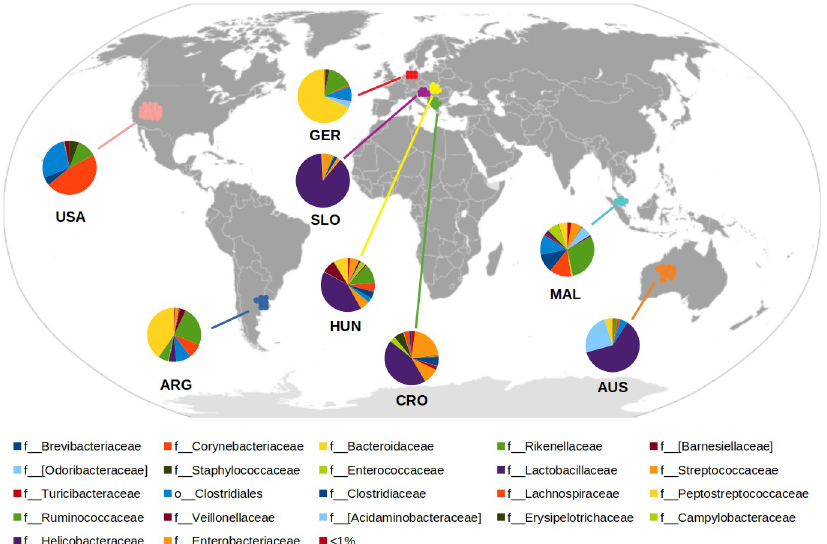
Fig 2. Geography map of chicken GIT microbiota at the family level. Different colors are used to indicate each individual taxon according to the country of origin designated as AUS: Australia, ARG: Argentina, CRO: Croatia, GER: Germany, HUN: Hungary, MAL: Malaysia, SLO: Slovenia, and USA: United States. The taxonomic classification: p_phylum, c_class, o_order, and f_family. https://doi.org/10.1371/journal.pone.0244724.g002 farm (AE). The analysis consisted of ET samples involves in the previously analysis, and other 17 samples of the same datasets from different ages (Table 1), and 27 samples obtained from CF (S1 Table). A total of 3032606 quality trimmed sequences and 1172 different OTUs, were obtained with an average number of sequences per sample of 49168, 49881, 69817, and 49297, for ET1, ET2, CP, and AE respectively. The distribution of the experimental and commercial datasets gathered into different groups according to the multidimensional scaling analysis (PCoA based on unweighted Uni- Frac distances of the 16S rRNA gene). PC1 clearly showed the differences between experimen- tal and commercial datasets, whereas PC2 displayed differences between each experimental trial (ET1 and ET2). Finally, PC3 allowed us to separate the data belonging to AE and CP (Fig 3). In addition, alpha diversity values confirmed two separate groups (ET and CF) according to both richness and diversity indexes (Table 4). Table 3. Alpha diversity indexes for chicken samples throughout geographic location.